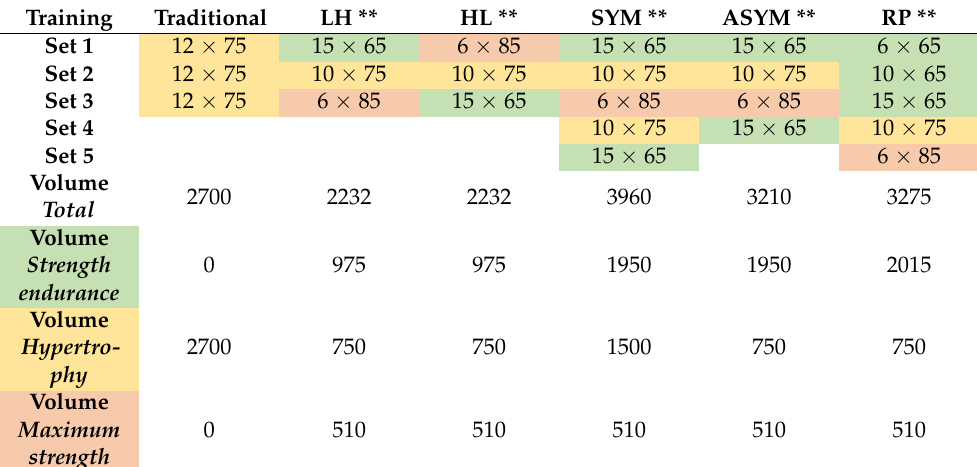
Table 1. Training volume difference * between pyramidal and resistance training, depending on if the training targets strength endurance (green), hypertrophy (orange) or maximum strength